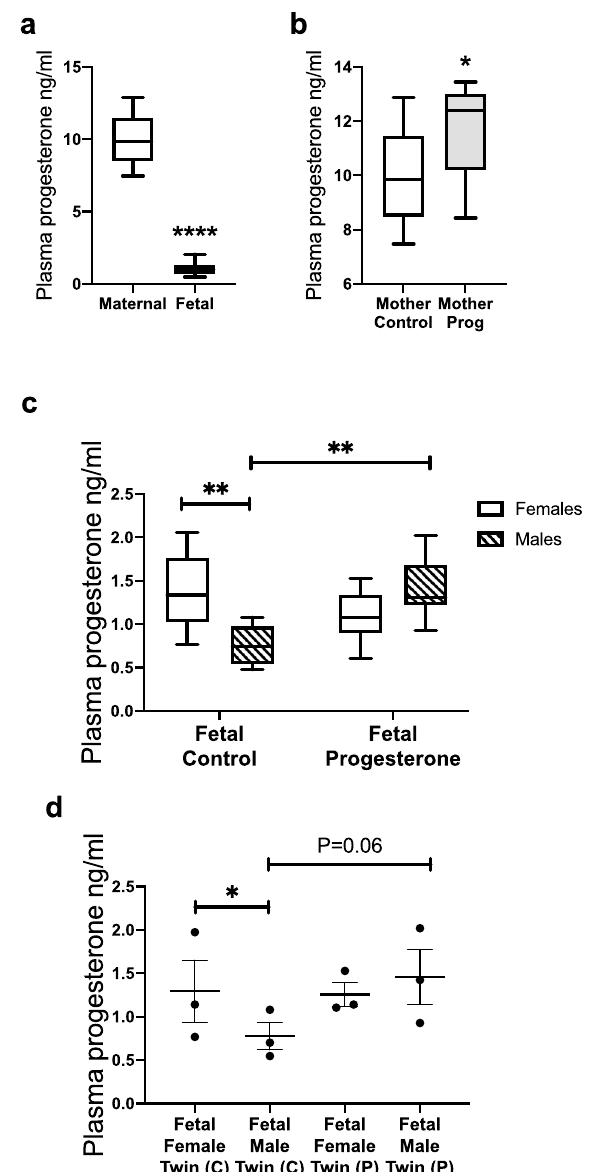
Figure 1. Fetal progesterone concentrations at d75 gestation. ( a ) Progesterone concentrations from the control ewes (n = 10) and their fetuses (n = 20). ( b ) Maternal progesterone was increased after the progesterone treatment (C = 10; P = 10). ( c ) Fetal female controls (n = 10) had higher progesterone concentration than fetal male controls (n = 10). Maternal progesterone administration had no effect on female fetuses (n = 13) but increased male fetal progesterone concentration (n = 7). ( d ) The difference in progesterone concentration was present in control male and female co-twins (n = 3). The sexually dimorphic effect of maternal progesterone treatment was seen in male/female co-twin pairs (C = 3; P = 3). Box plot whiskers are lowest and highest observed values, box is the upper and lower quartile, with median represented by line in box. Unpaired, two- tailed Student’s t test was used for comparing means of two treatment groups with equal variances accepting P < 0.05 as significant. Maternal progesterone was analysed using unpaired, one-tailed Student’s t test. The effect of progesterone treatment on female and male fetuses was analysed using two-way ANOVA with Tukey post hoc test. Co-twin fetal serum progesterone level between male and female was analysed using a paired two-tailed Student’s t test and between progesterone and control a one-tail unpaired Student’s t test (* P < 0.05; ** P < 0.01; *** P < 0.001; **** P <